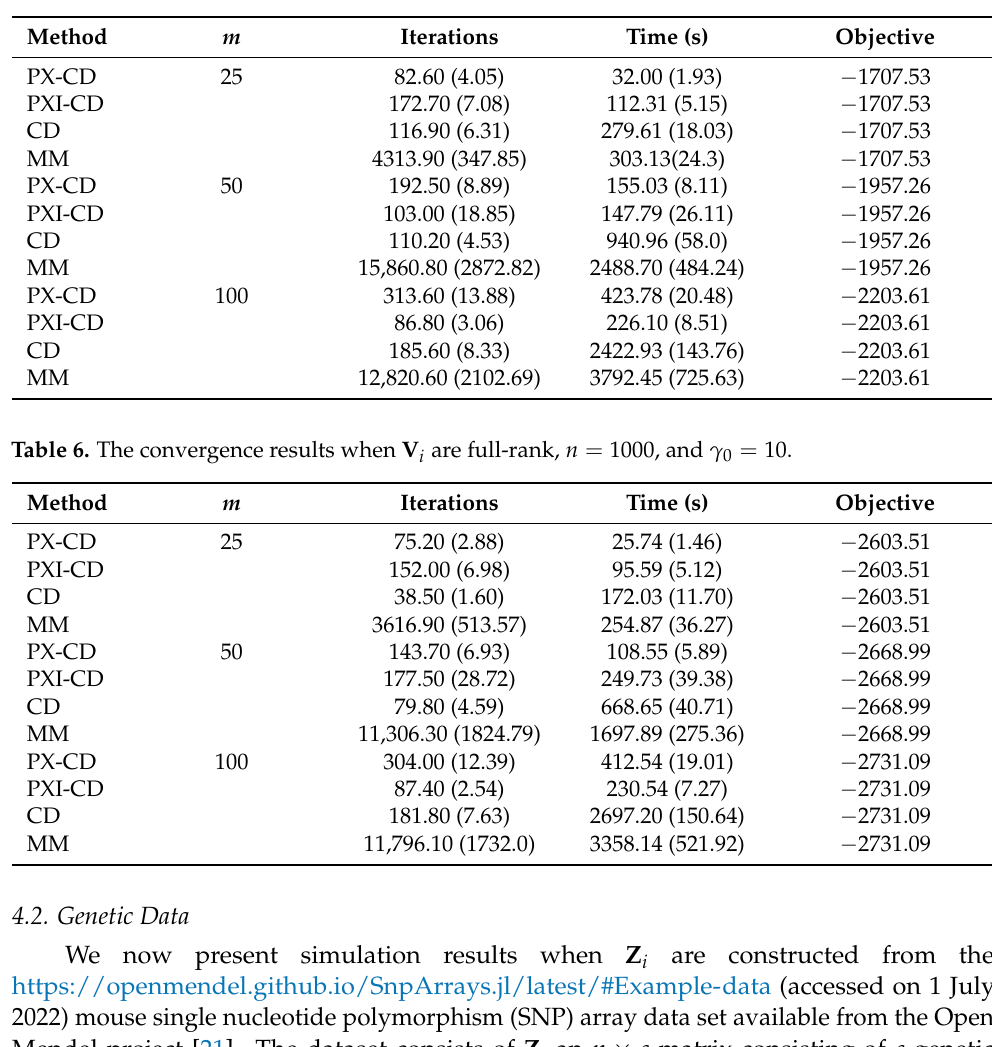
Table 5. The convergence results when V i are full-rank, n = 1000, and γ 0 = 1.